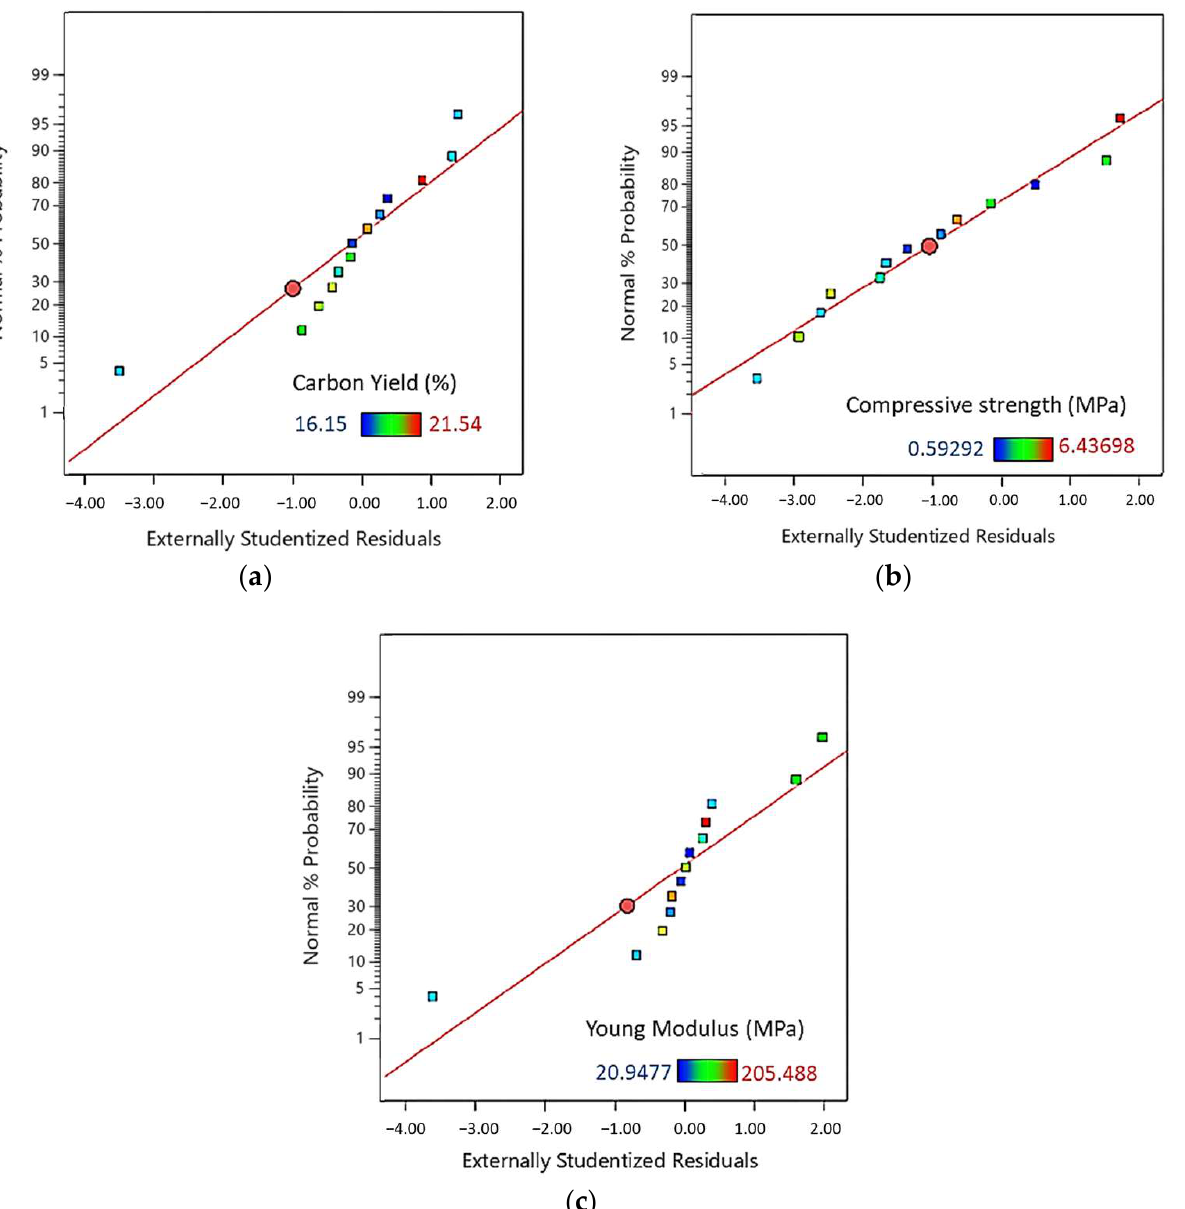
Figure 6. Normal probability plot for residuals for: the ( a ) carbon yield, ( b ) compressive strength, and ( c ) Young’s modulus. The numerical values for these properties increase from dark blue to red.